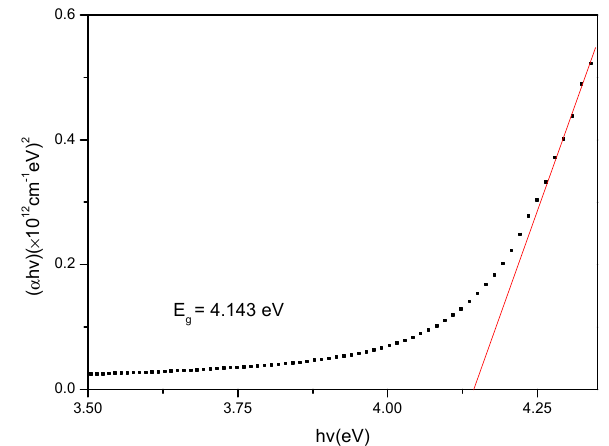
Figure 7. Optical band gap for CTA-NCC thin film.